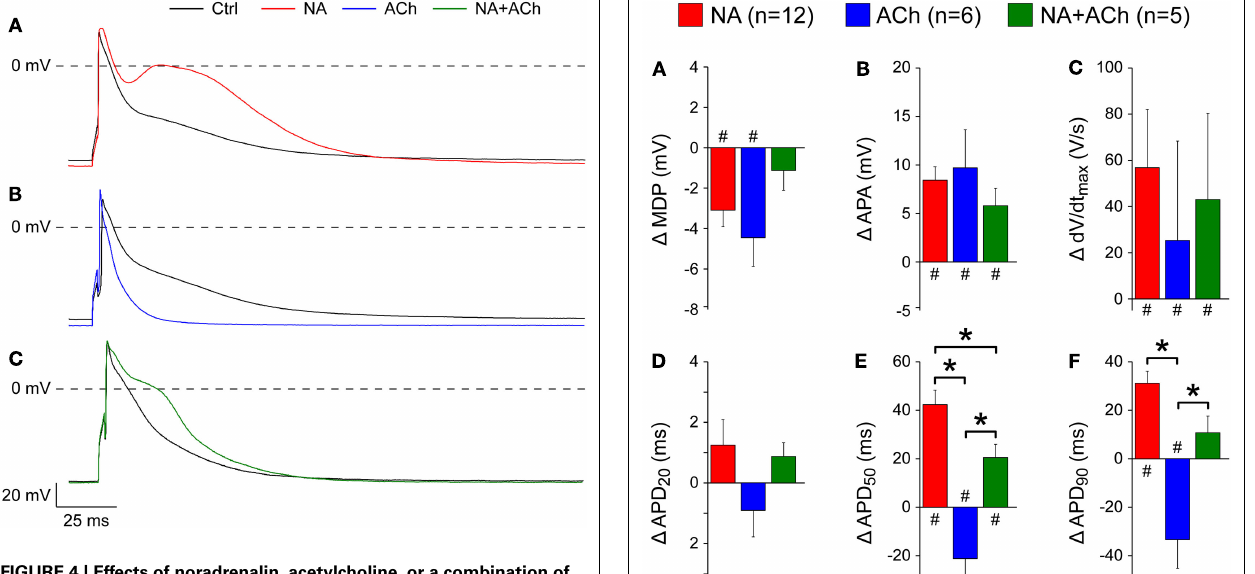
FIGURE 4 | Effects of noradrenalin, acetylcholine, or a combination of both on the action potentials of isolated rabbit left atrial myocytes. (A) Typical action potentials of an isolated atrial myocyte under control conditions (“Ctrl,” black line) and in the presence of 1 μ M noradrenalin (“NA,” red line). (B) Typical action potentials of an isolated atrial myocyte under control conditions (“Ctrl,” black line) and in the presence of 1 μ M acetylcholine (“ACh,” blue line). (C) Typical action potentials of an atrial myocyte under control conditions (“Ctrl,” black line) and in the presence of both noradrenalin and acetylcholine (“NA + ACh,” green line).